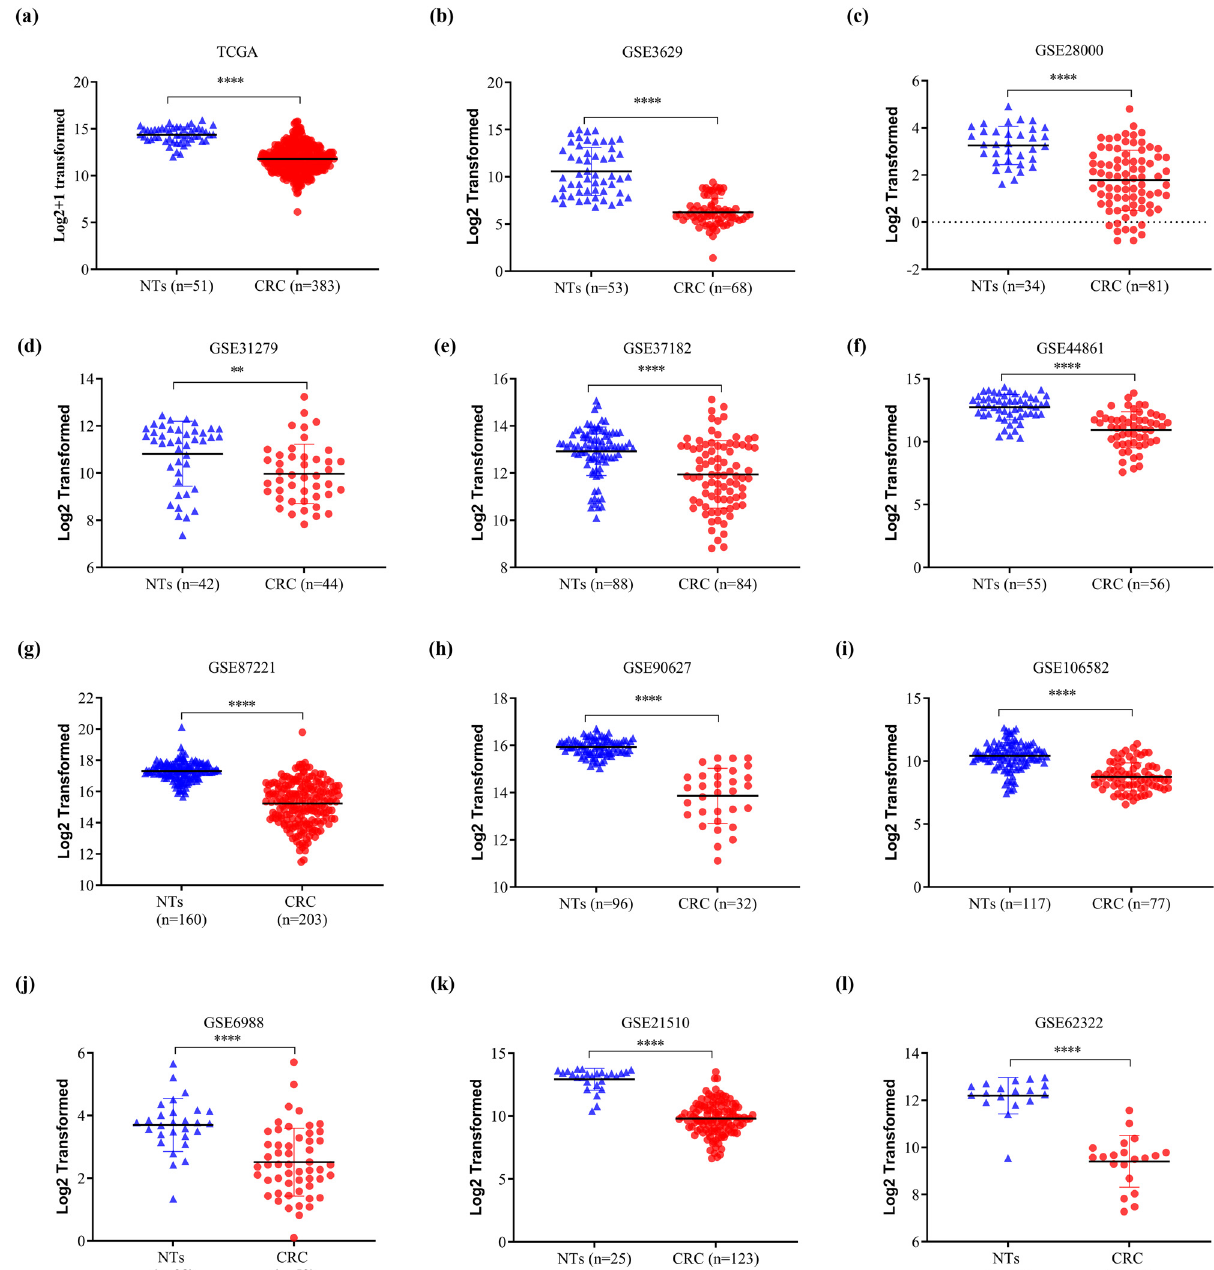
Figure 1: SELENBP1 expression is consistently downregulated in CRCs. The expression of SELENBP1 was compared between colorectal NTs and CRCs in 12 datasets from the TCGA and GEO databases ( a – l ) . ** p < 0.01; **** p < 0.0001 vs the control